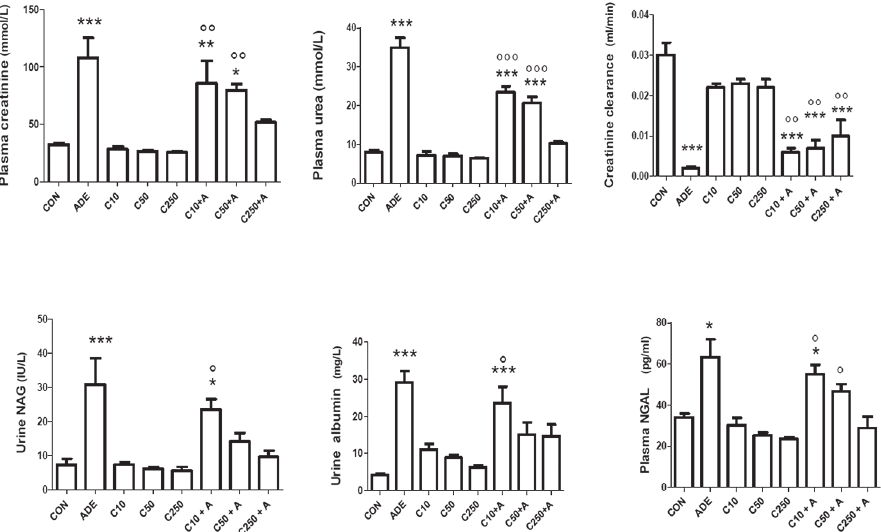
Fig 2. Effect of chrysin treatment on creatinine clearance, plasma concentrations of creatinine, urea and neutrophil gelatinase-associated lipocalin (NGAL), urinary albumin concentration and N-acetyl- β - D-glucosaminidase (NAG) activity in control rats and rats treated either singly or concomitantly with either adenine (ADE) or chrysin (C) at doses of 10, 50 or 250 mg/kg. Each column and vertical bar is a mean ± SEM (n =